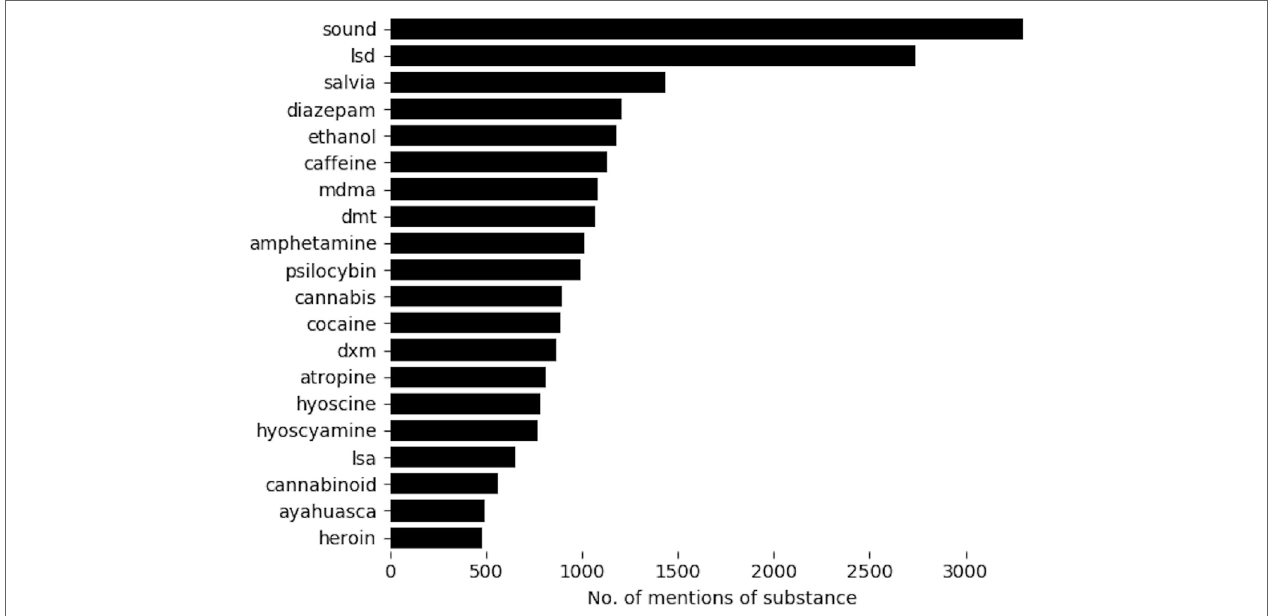
FigUre 1 | Top 20 most frequently mentioned substances. x -Axis denotes number of posts in which the substance was mentioned at least once. MDMA, 3,4-methylenedioxymethamphetamine, also known as ecstasy; DMT, N , N -dimethyltryptamine; DXM, dextromethorphan; LSA, lysergic acid amide, also known as